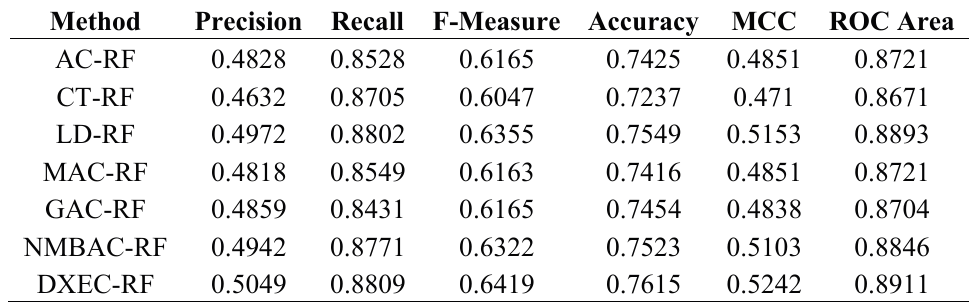
Table 4. Performance comparison of seven methods on the Human All dataset using Silver Human model.